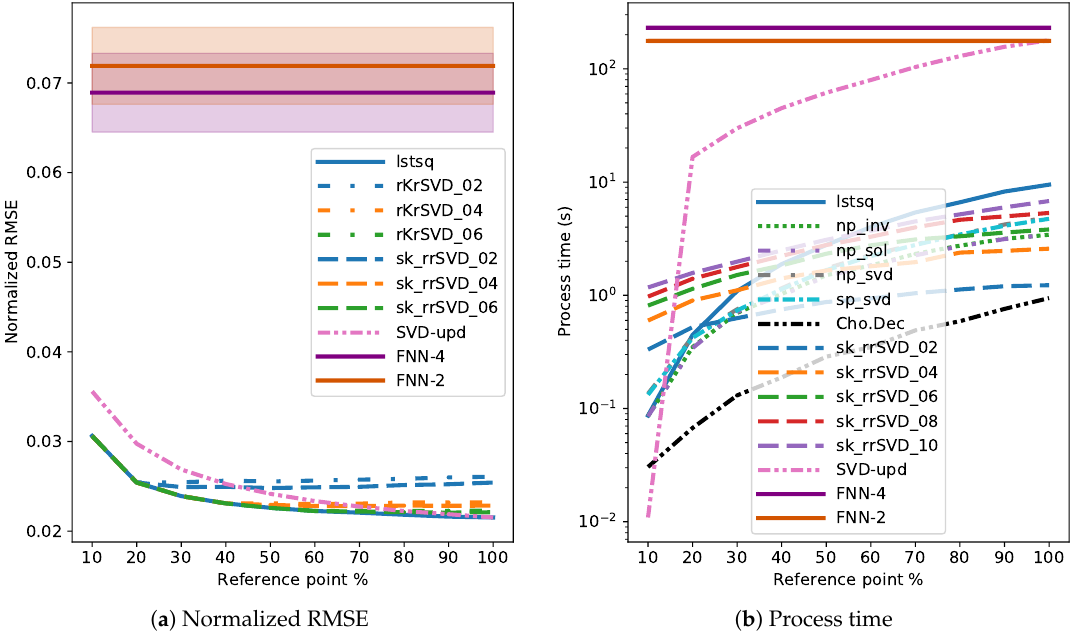
Figure A3. Normalized RMSE values ( a ) and process time in seconds taken to compute Equation (1) ( b ) as a function of reference point percentage for the Airplane Companies Stocks dataset. In ( a ) for MLM, only methods that at any reference point percentage differ from Lstsq with Kruskal–Wallis H test are shown along Lstsq .